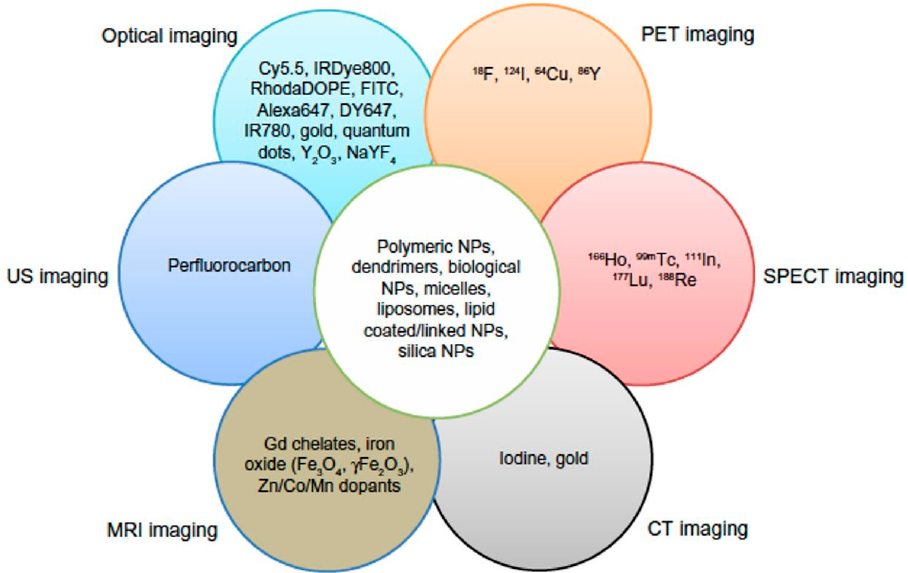
Figure 4. Incorporation of multicomponent imaging agents in a nanoplatform for multimodality imaging (Adapted with permission from [7]. Copyright 2014 DOVE Medical Press).